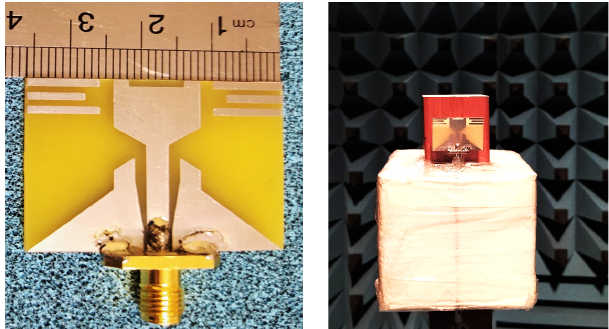
FIGURE 9. Fabricated prototype antenna with attached SMA.